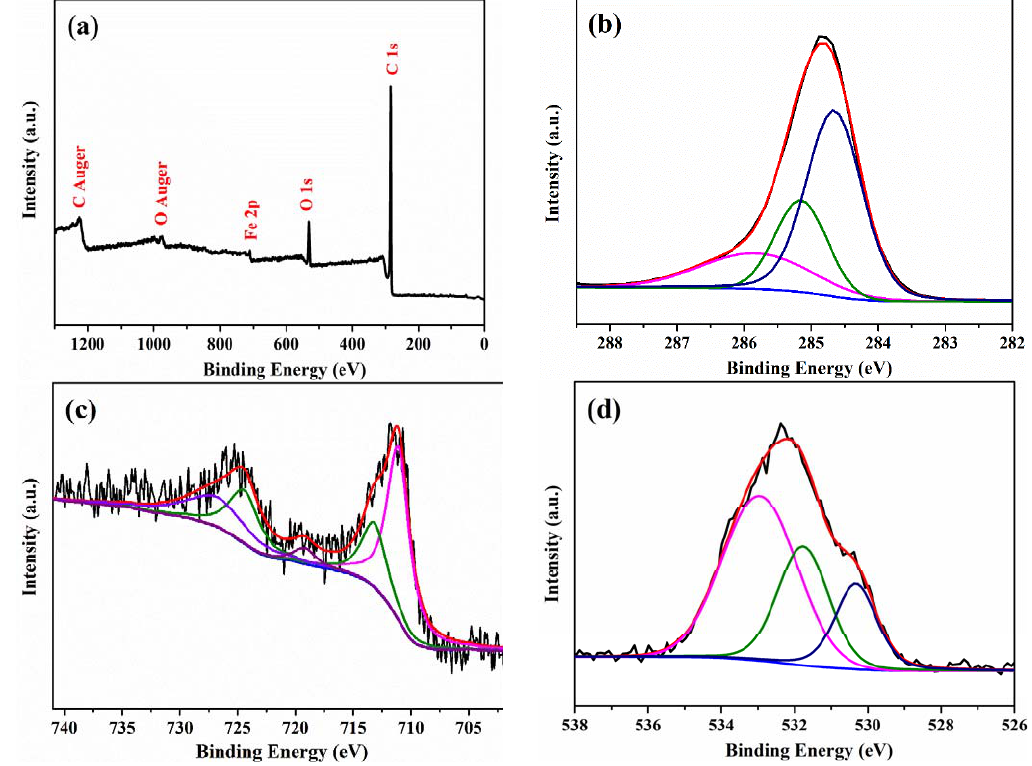
Figure 6. ( a ) XPS survey spectrum; high ‐ resolution XPS spectra of ( b ) C 1s; ( c ) Fe 2p and ( d ) O 1s for CBC ‐